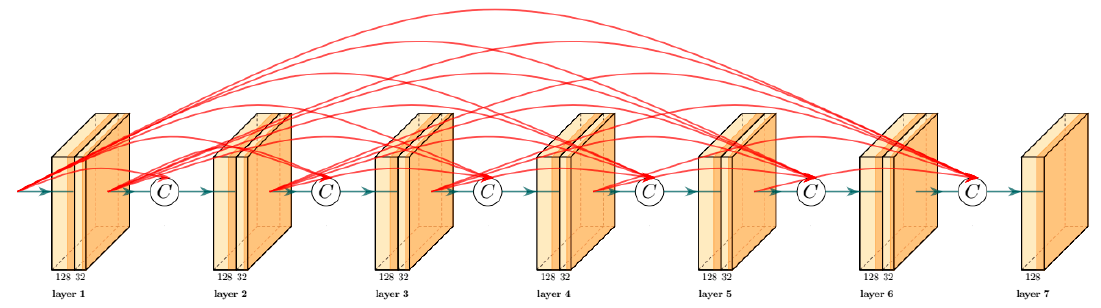
Figure 3. The structure of dense blocks used in the feature fusion module. Original cuboids represent convolutional layers. The 128 and 32 below cuboids represent the number of channels.